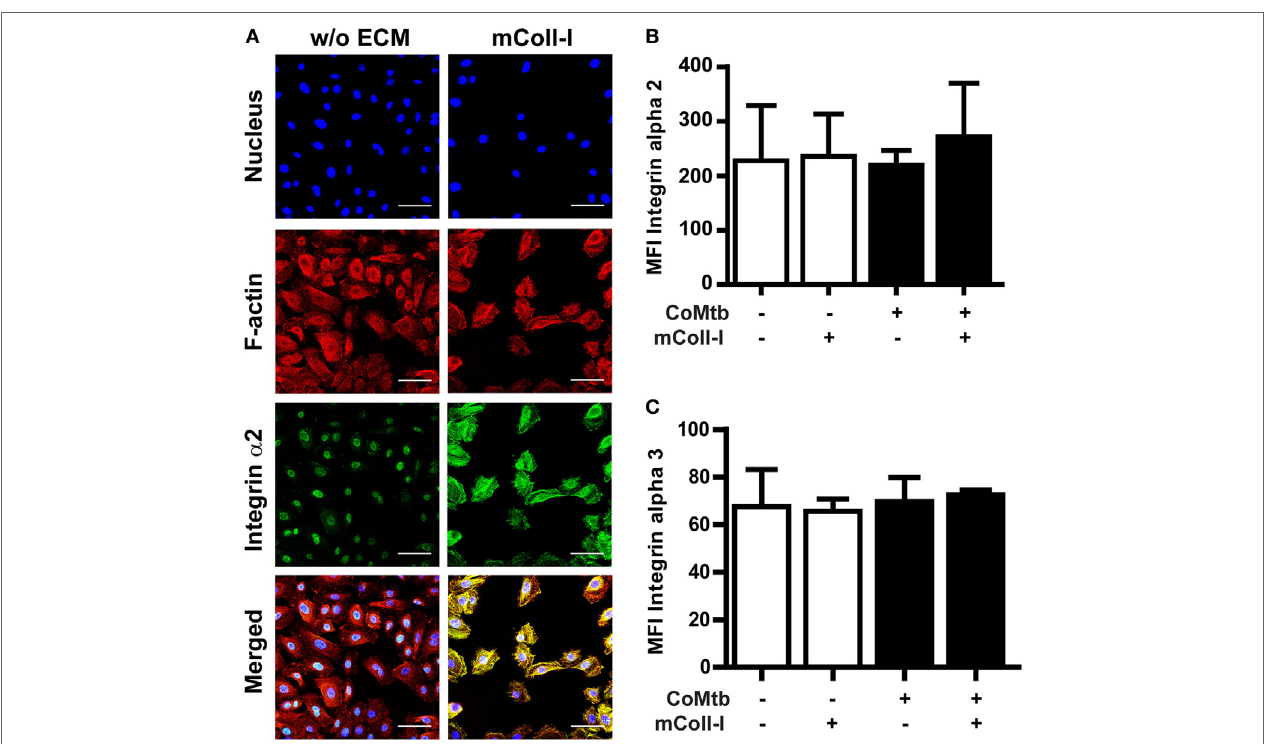
FigUre 3 | Matrix type I collagen induces α 2 β 1 integrin clustering and actin colocalization without affecting integrin surface expression. Human bronchial epithelial cells (HBECs) were cultured in the in the presence of matrix or soluble Coll-I or without extracellular matrix (ECM) as controls and stimulated with CoMtb or control medium. (a) Confocal microscopy figures of CoMtb-stimulated HBECs. Cells were stained with DAPI (blue) for nucleic acids, phalloidin conjugated with Alexa Fluor 594 (red) for F-actin, and FITC-conjugated anti-integrin α 2 antibodies (green) for integrin subunit α 2. Yellow color shows co-localization of F-actin and integrin α 2 β 1 in merged images. Scale bar: 50 µm. (B,c) Control and CoMtb-stimulated HBECs were labeled with FITC-conjugated anti-integrin α 2 or α 3 and analyzed by FACS. FITC-conjugated mouse IgG1 was used as isotype control. Plots show mean fluorescence intensities (MFI) and SD for (B) α 2 and (c) α 3 integrins of